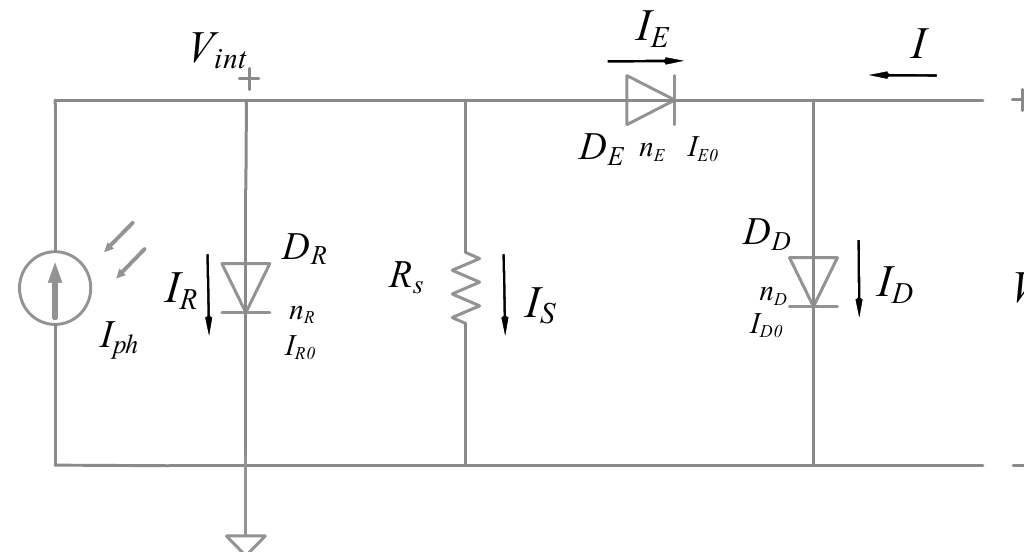
Figure 1. Our previous lumped-parameter equivalent circuit of organic solar cells (OSCs).